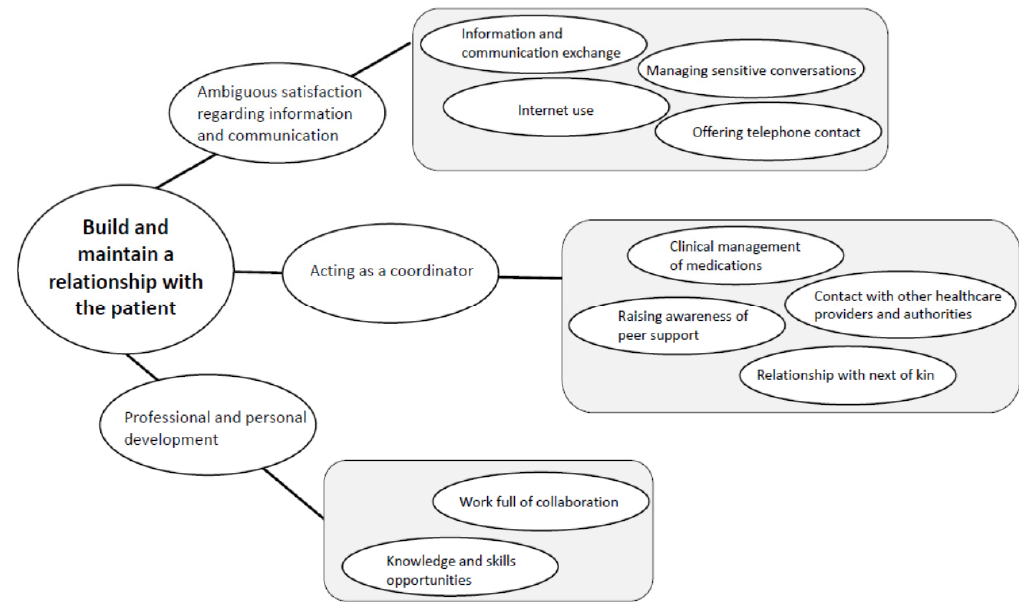
Figure 2. Summary of the subcategories, categories and the main theme.